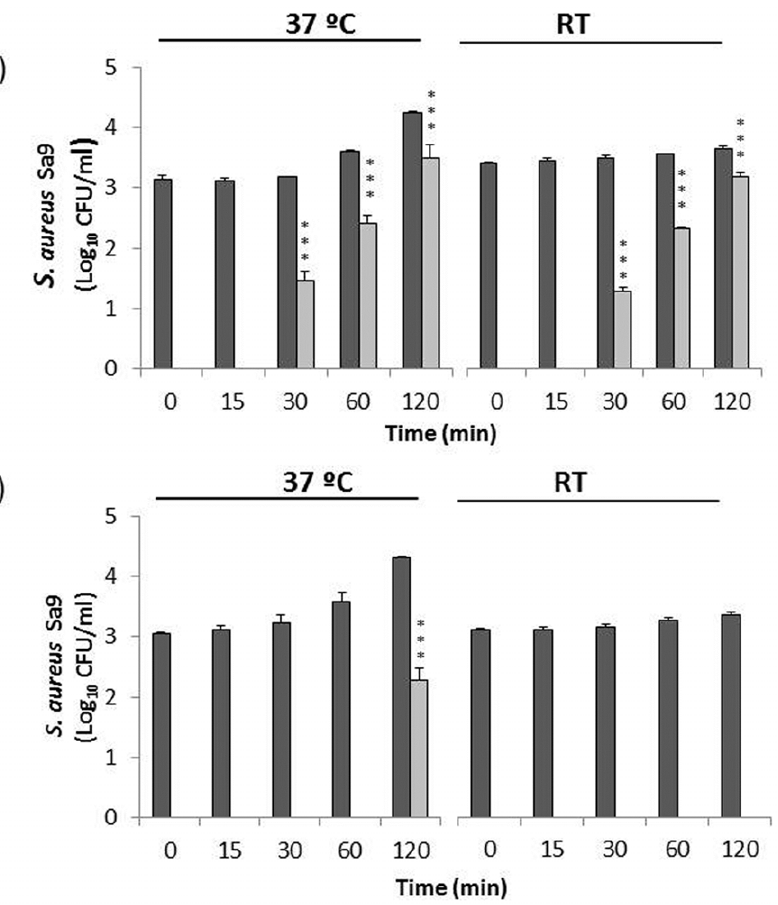
Figure 3. Antimicrobial activity of CHAPSH3b protein in skim milk. Milk was inoculated with 10 3 CFU/ml of S. aureus Sa9 and incubated in the presence of 1.65 m M CHAPSH3b for 0, 15, 30, 60 and 120 min either at RT or 37 u C in: A) raw milk and B) pasteurized milk. Dark grey bars indicate S. aureus Sa9 control culture and light grey bars S. aureus Sa9 + CHAPSH3b. Values, expressed as log CFU/ml, are the means 6 standard deviations of two independent experiments. Bars having asterisks are significantly different from the control (*** P , 0.001). S. aureus detection threshold ( , 10 CFU/ ml).